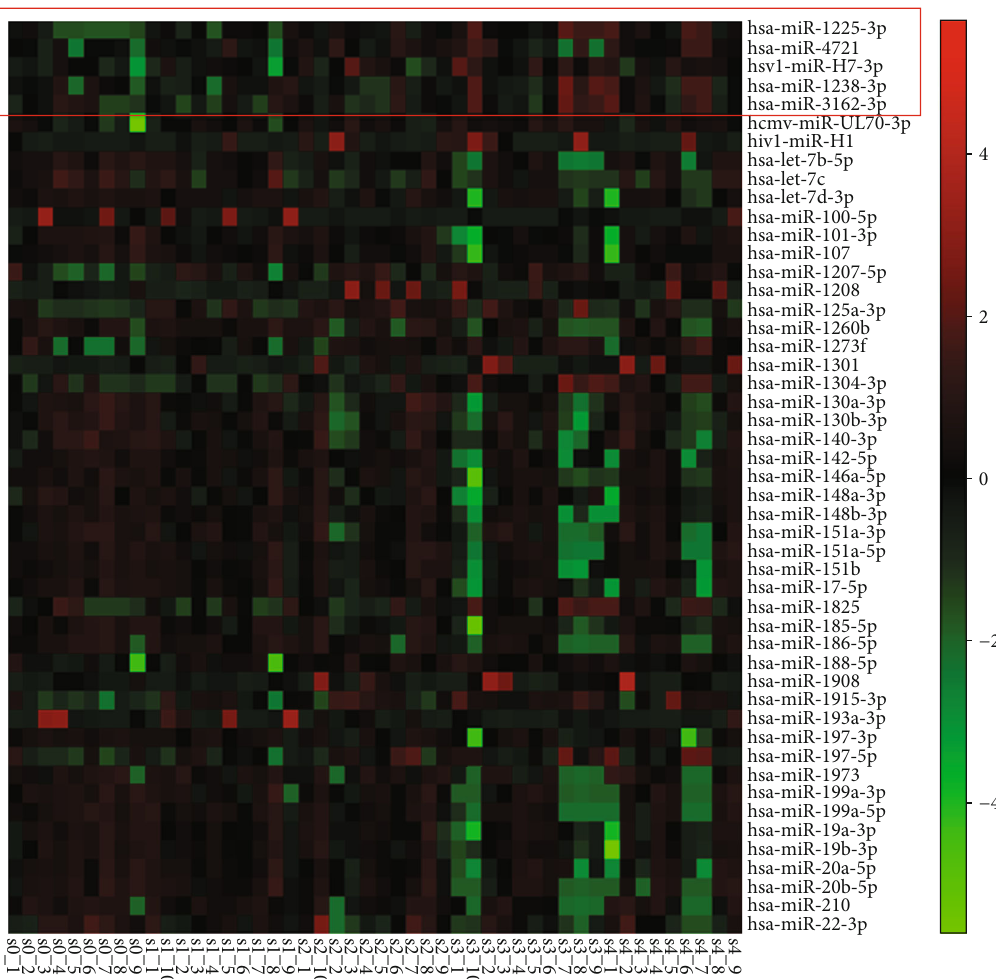
Figure 1: Heatmap of top 50 of 140 di ff erent miRNAs in patients with hepatitis B virus infection and hepatic fi